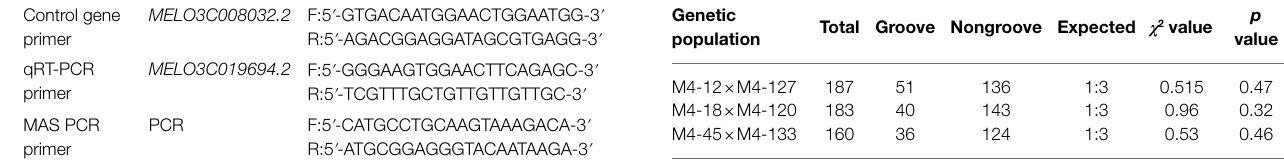
TABLE 2 | Genetic analysis of the fsg trait among F 2 segregated populations. Genetic population